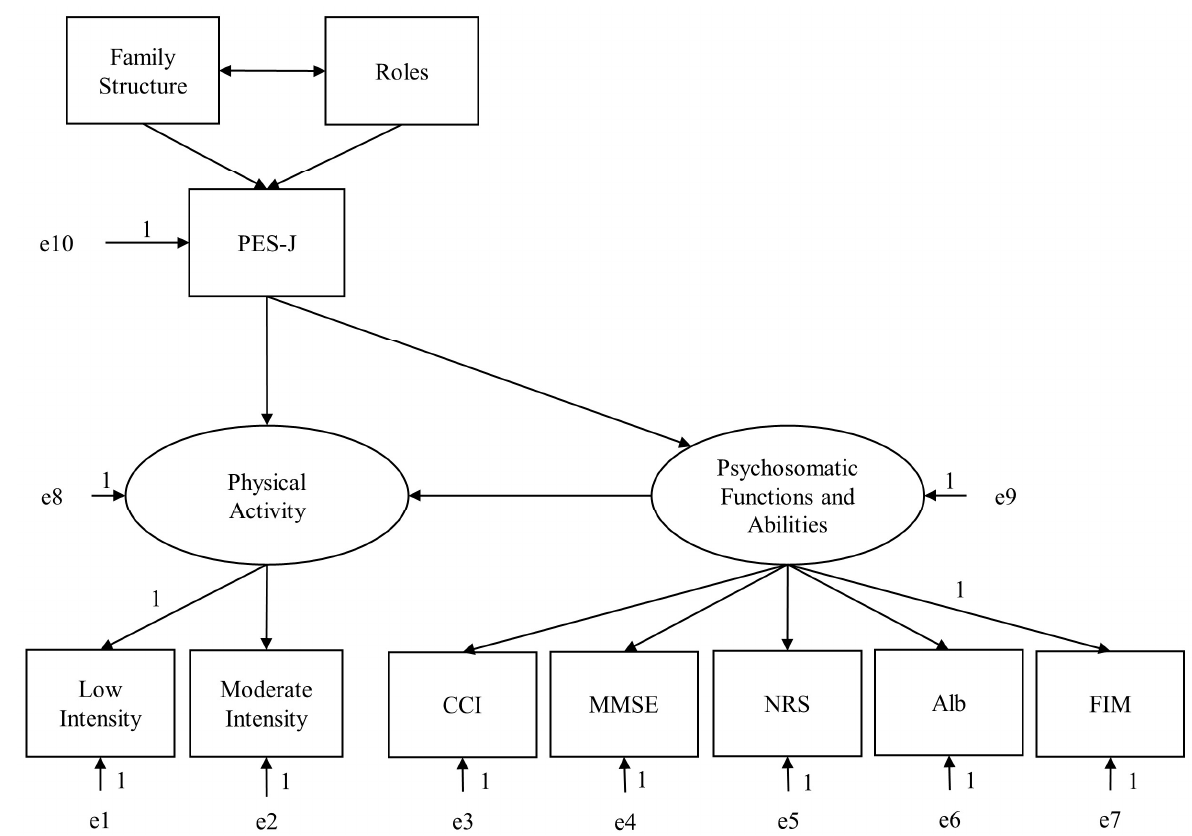
Figure 3. Form of the causal hypothesis model used in the analysis. PES-J: Patient Empowerment Scale—Japanese Version, CCI: Charlson Comorbidity Index, MMSE: Mini-Mental State Examination, NRS: Numerical Rating Scale, Alb: serum albumin test, FIM: functional independence